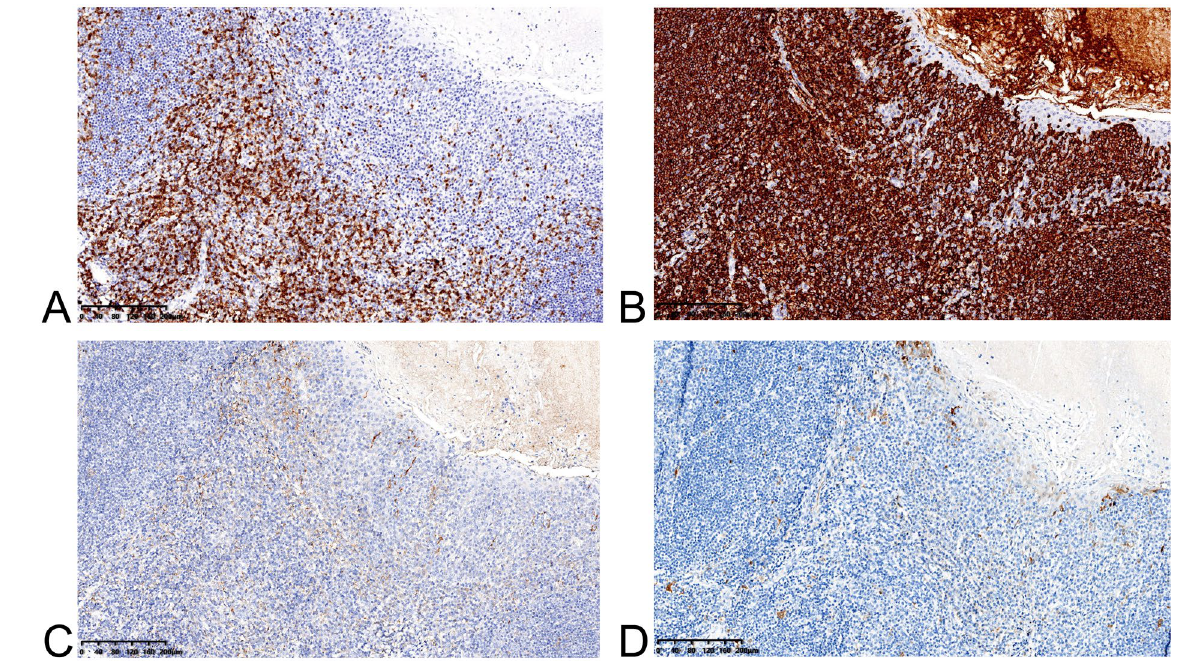
Figure 4. ( A ) CD3 staining highlights interfollicular T-cell-rich zone. ( B ) CD20 staining shows B-cell-rich follicles. Note the presence of more B cells within the lymphoepithelium (blue arrow). ( C ) PD-L1 staining shows a scattered positive in lymphocytes and histocytes, while epithelium is negative. ( D ) P16 is negative in both lymphocyte and epithelium.